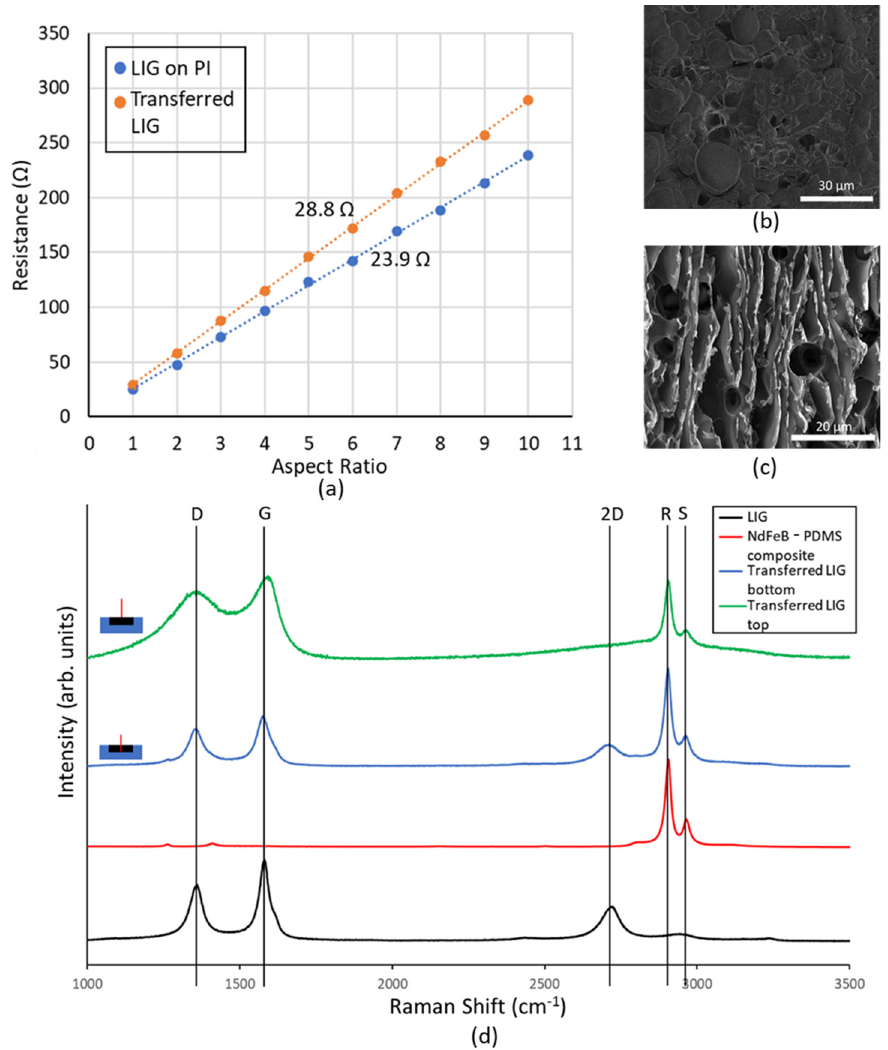
Figure 3. ( a ) Impact of LIG transfer process on sheet resistance, ( b ) SEM image of transferred LIG surface, ( c ) SEM image of native LIG surface, and ( d ) Raman spectrum of transferred LIG, native LIG, and magnetic composite.